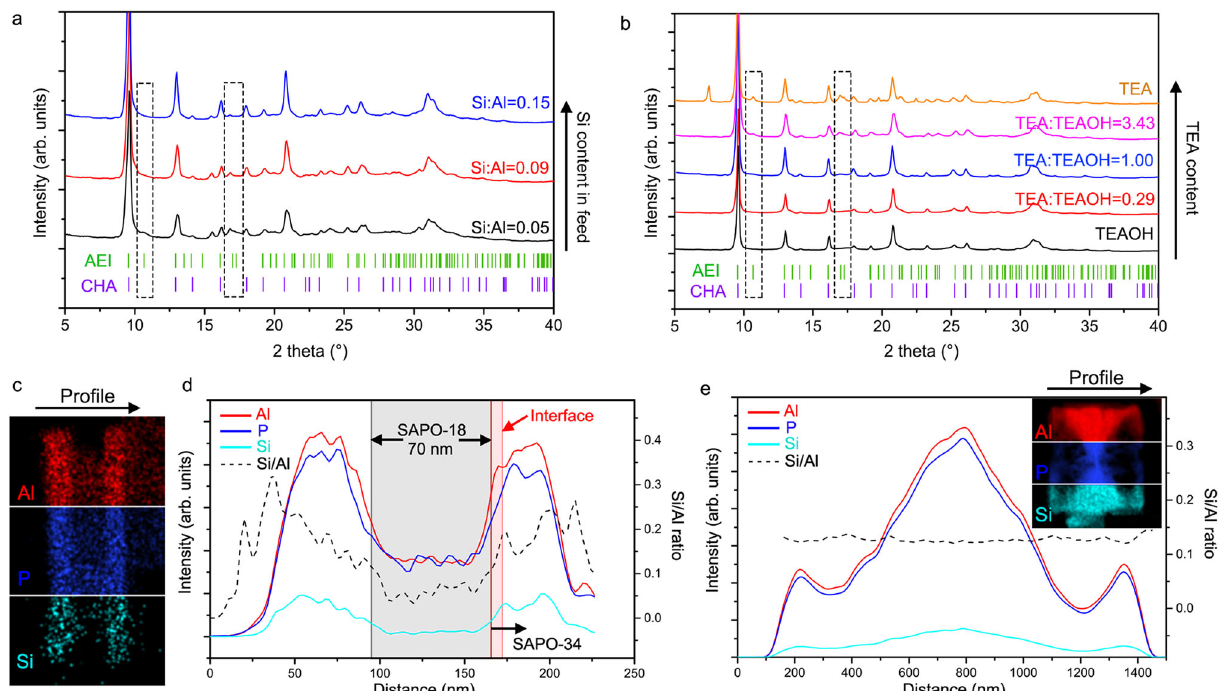
Fig. 4 SAPO-34/18 intergrowth controlled by Si contents and templates. a PXRD results of SAPO-34/18 intergrowth synthesized with different Si contents in feed. The blue, red, and black lines represent the PXRD results of SAPO-34/18 samples with Si/Al ratios in feed of 0.15, 0.09, and 0.05, respectively. b PXRD results of SAPO-34/18 intergrowth directed by different combinations of TEAOH and TEA dual templates. The yellow, pink, blue, red, and black lines represent the PXRD results of SAPO-34/18 samples with TEA/TEAOH ratios of ∞ , 3.43, 1.00, 0.29, and 0 respectively. c EDS mapping of the sandwich SAPO-34/18 crystal in Fig. 3h. d Elemental pro fi le analysis showing the distribution of Al, P, and Si elements (the red, blue, and cyan lines) and the change of Si/Al ratio (the black dashed line) along the pro fi le direction. e Elemental pro fi le analysis and the EDS mapping of the hierarchical SAPO- 34/18 crystal in Fig.